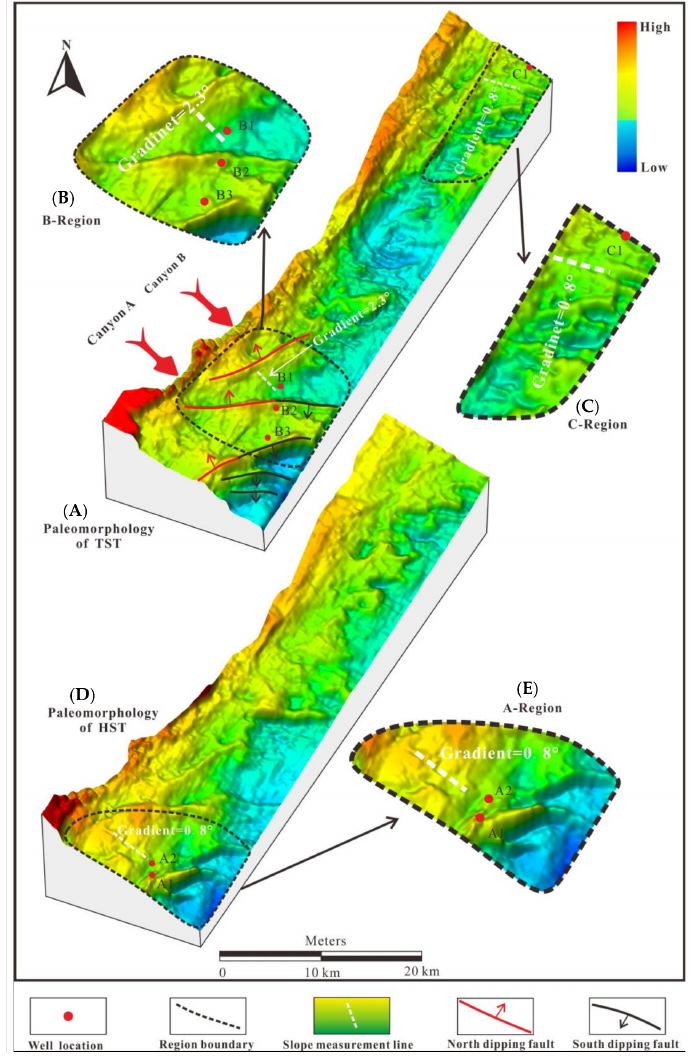
Figure 10. Paleomorphology of the Liaoxi uplift and slope. ( A ) Paleomorphology of Liaoxi uplift and slope in TST. ( B ) Slope gradient in region B is 2.3 ◦ . ( C ) The slope gradient in region C is 0.8 ◦ .